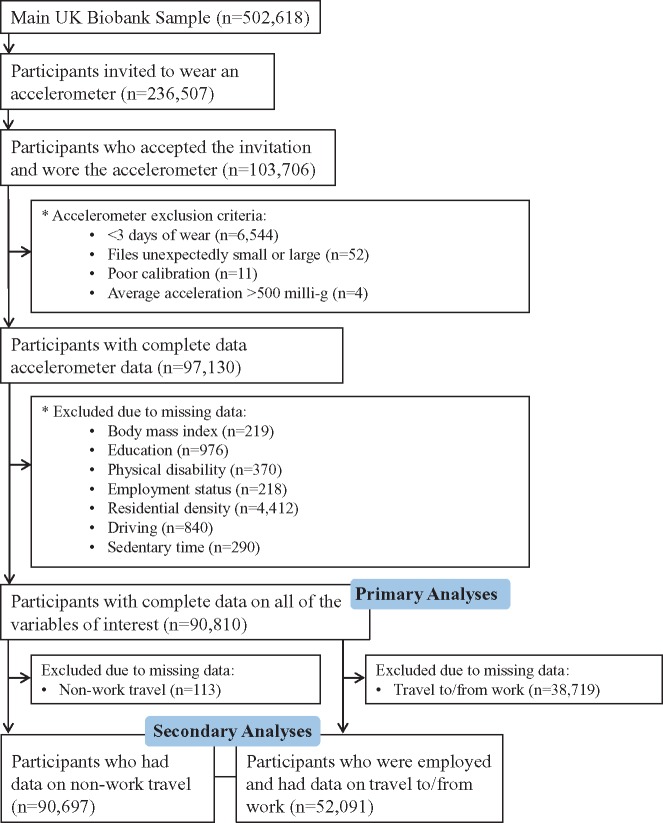
Selection of UK Biobank participants into the present study.